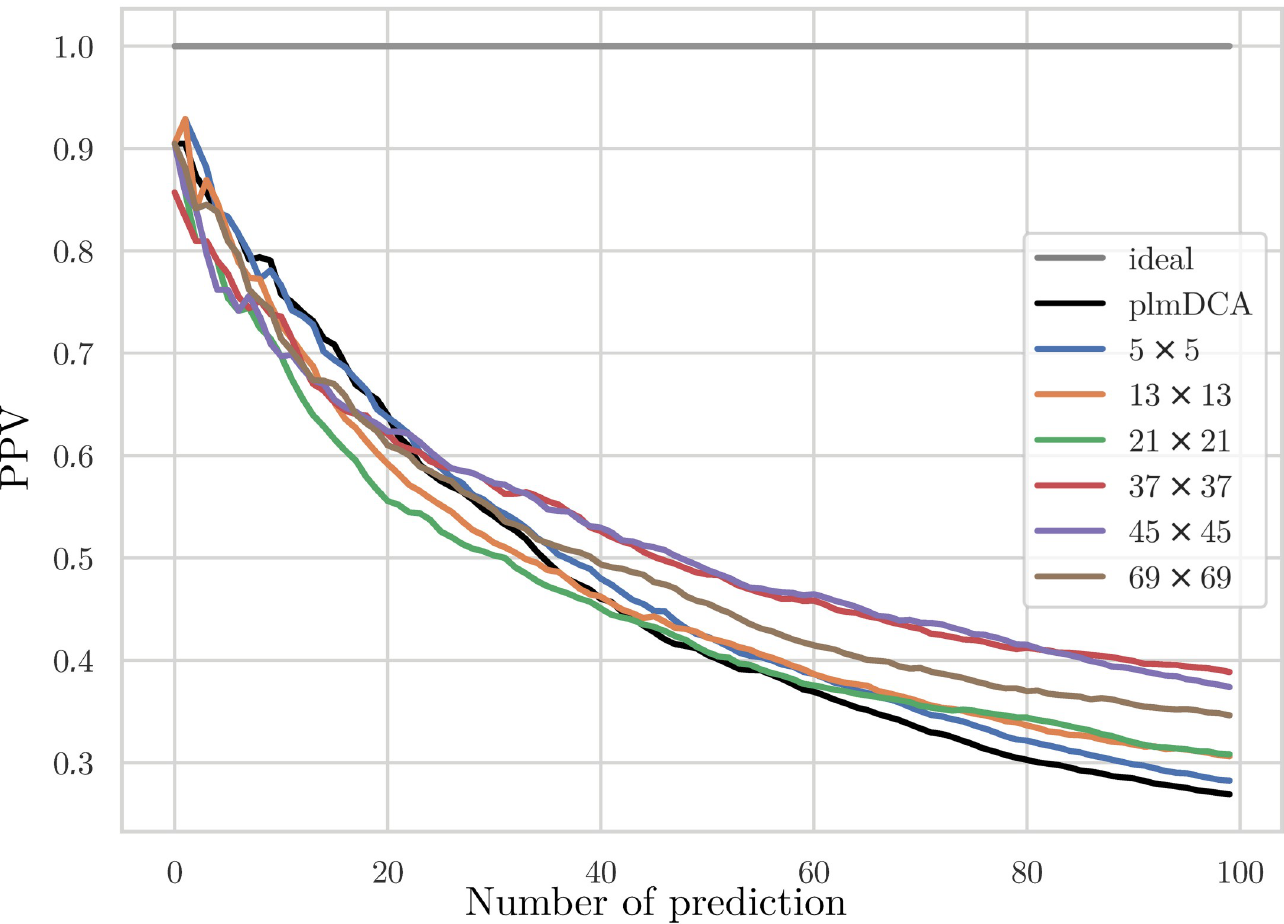
Fig 9. Positive predictive values of FilterDCA for inter-protein contact prediction. PPVs are shown as a function of the number of predictions, averaged over the different protein-protein interactions in the test set. Different filter sizes are compared to standard